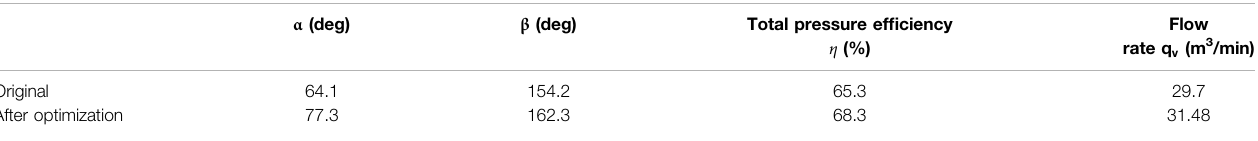
TABLE 3 | Structural parameters corresponding to the optimal